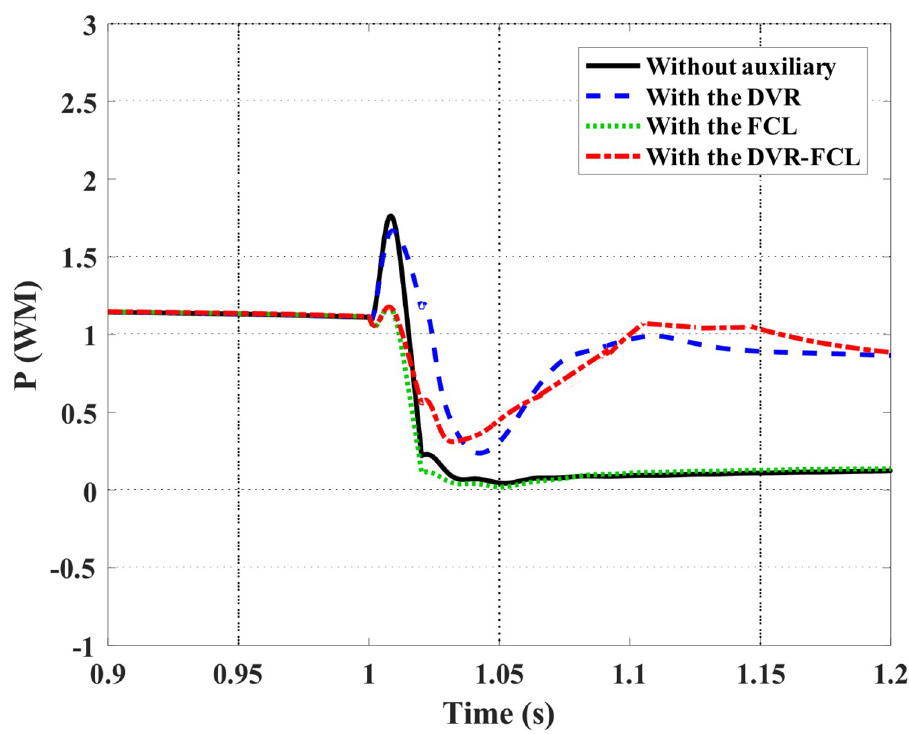
Fig 10. Active power of the DFIG subject to the symmetrical fault.